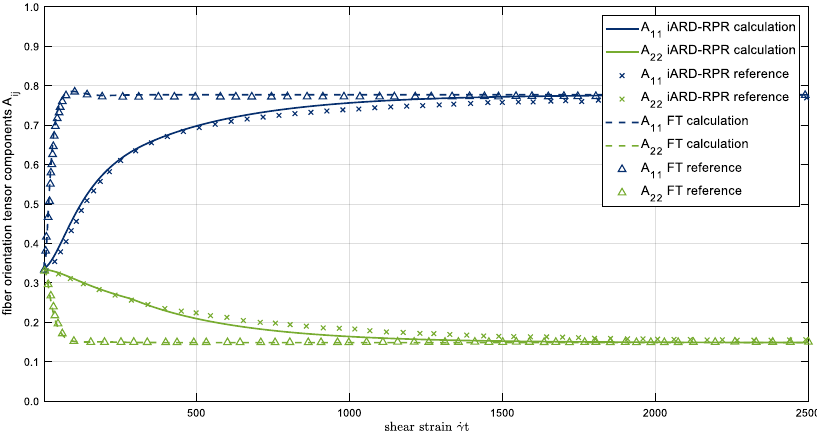
Figure 23. Validation of the implemented fiber orientation calculation within the calibration tool.